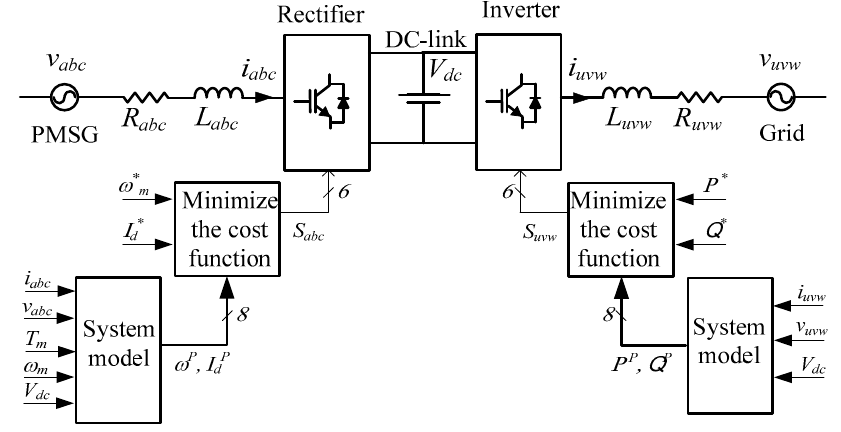
Figure 4. Model predictive controller (MPC) for an active front end (AFE rectifier) rectifier and two-level voltage source inverter.